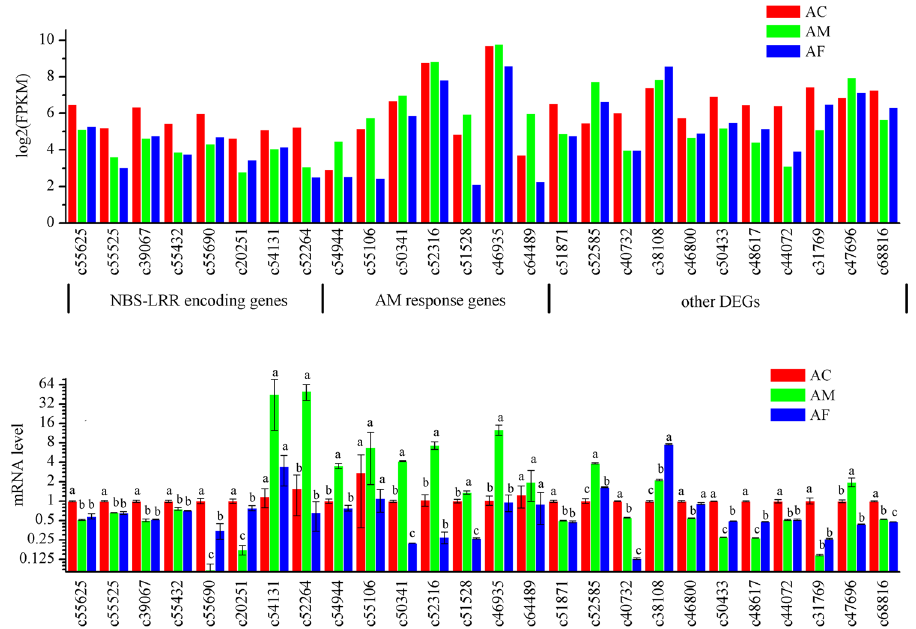
Figure 4. Quantitative real-time PCR (qRT-PCR) validations of 26 differentially expressed genes in AC (red), AM (green) and AF (blue). For each qRT-PCR validation, three technical replications were performed, beta- tubulin gene was used as internal control. All results were expressed as means ± standard error (SE) of the number of experiments. The lowercase ‘a’, ‘b’ and ‘c’ indicated that statistically significant difference of mRNA level was considered on an error probability of p < 0.05 by one-way ANOVA using Duncan’s multiple-range test.